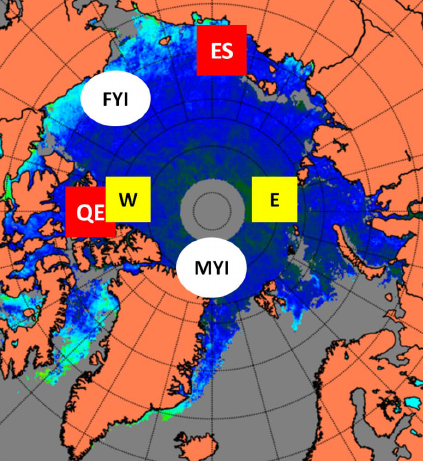
Figure 1. Schematic depiction of the case study locations (the size of the labels does not correspond to the real size of the studied area, see text for area sizes). White circles depict locations for the time sequence analysis in summer 2009, in the Beaufort Sea, FYI (red curves in Fig. 2) and North Greenland, MYI (blue curves in Fig. 2). Yellow squares show locations for two sites in both 2007 and 2011, namely in Barents Sea (E) and north to the Queen Elizabeth Is- lands (W) (Fig. 5). Red squares depict the locations of two sites be- tween the Queen Elizabeth Islands (Fig. 10) and in the East Siberian Sea (Fig. 9), where the MPF temporal behaviour was compared for years